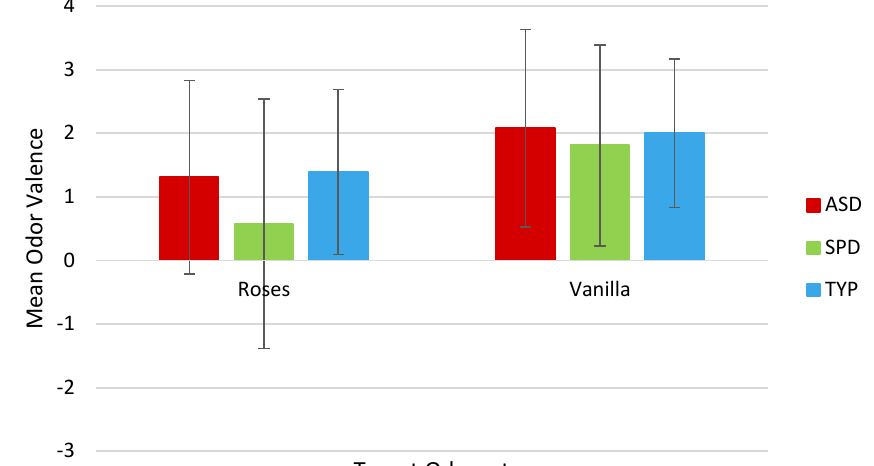
Figure 3. Mean odor valence scores by group, based on 7-point Likert Scale. −3 = Very Unpleasant, 0 = Neutral, +3 = Very Pleasant. No significant differences in odor valence were observed between the three groups at α = 0.05. ASD = children with Autism Spectrum Disorder; SPD = children with demonstrated Sensory Processing Dysfunction; TYP = Typically Developing children.